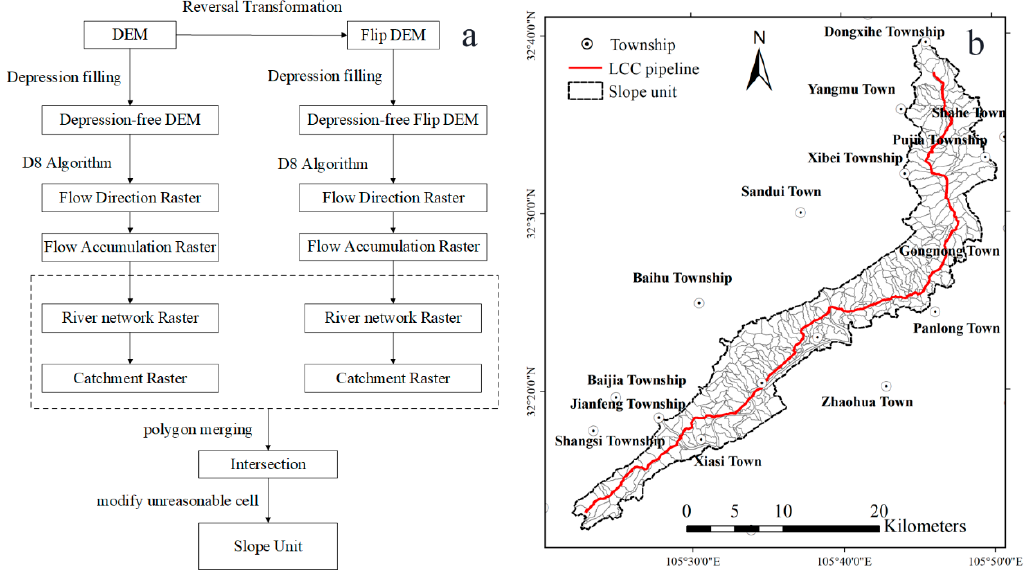
Figure 2. Flow chart for obtaining slope ( a ) and all slope units ( b ).